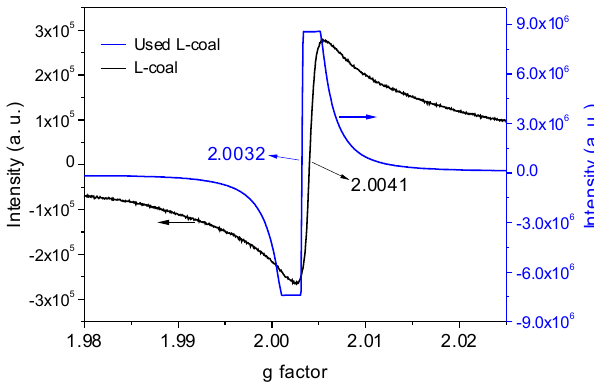
Figure 5. EPR spectra of L-coal powder and used L-coal powder.